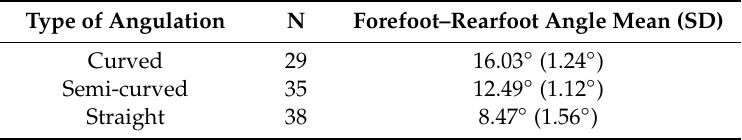
Table 2. Final cluster centroids.